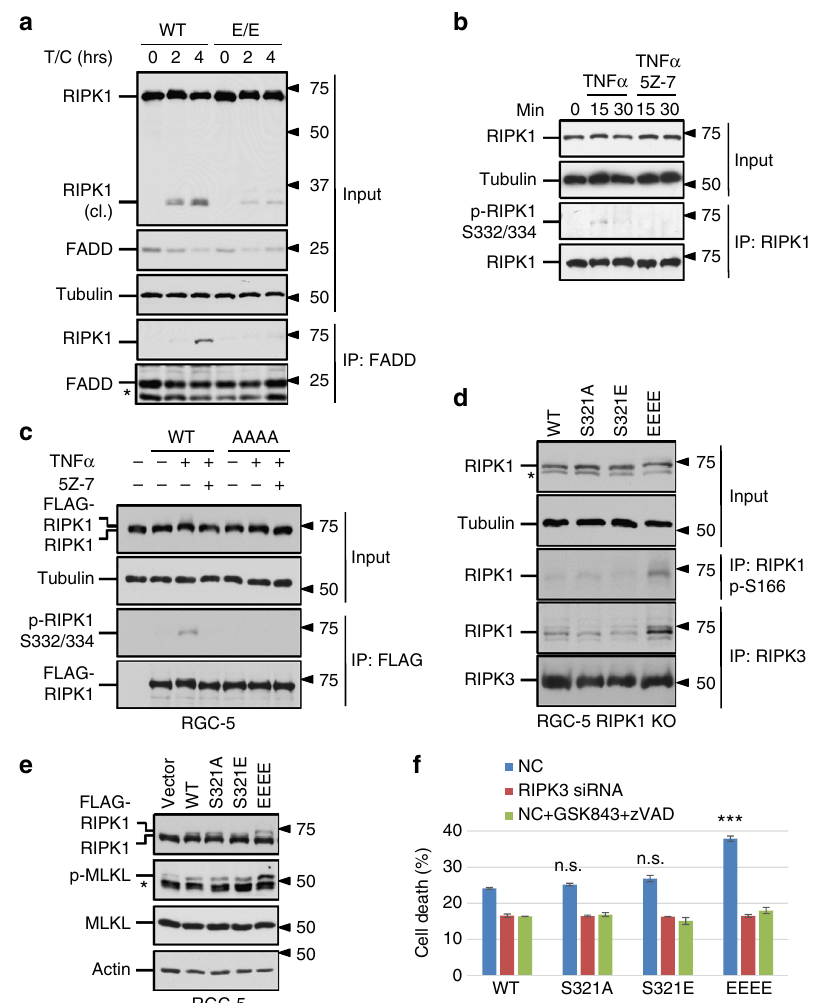
Fig. 7 Hyperactivation of RIPK1 mediated by TAK1 sensitizes cells to necroptosis. a S321E mutation suppresses RIPK1 cleavage and RIPK1-FADD interaction induced by TNF α /CHX. The cells were treated with TNF α (50 ng/ml) and CHX (1 µ g/ml) for 2 or 4 h. Co-immunoprecipitation was performed with FADD antibody. b TNF α induces RIPK1 S332/334 phosphorylation. RGC-5 cells were treated TNF α (10 ng/ml) with or without 5Z-7 (0.5 µ M). RIPK1 was isolated by immunoprecipitation and detected by p-RIPK1 S332/334 and RIPK1 total antibodies. c RIPK1 S321/332/334/336A (AAAA) mutation blocks TNF α